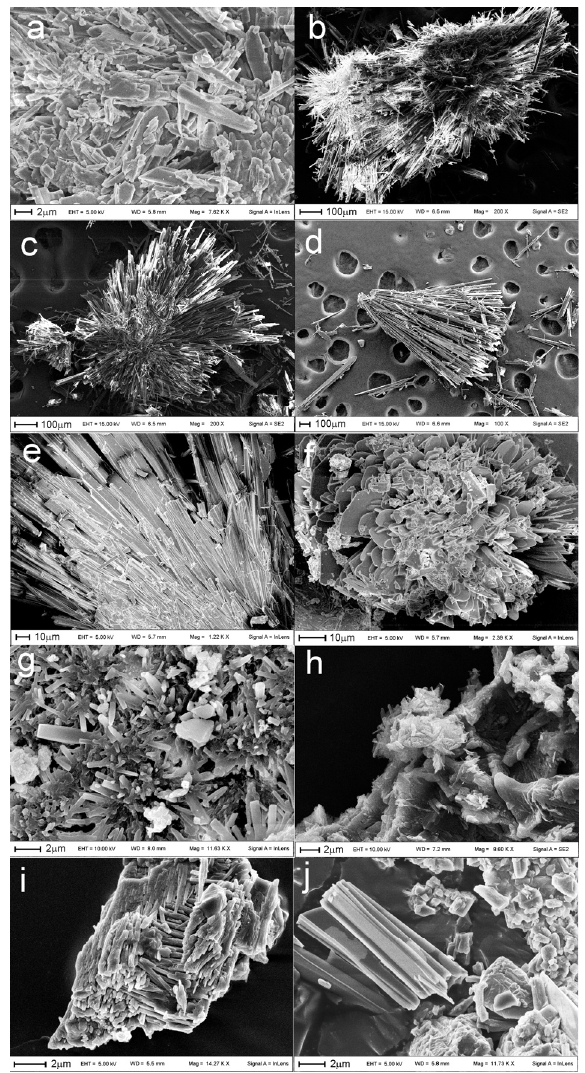
Figure 5. SEM images of Pristine-Tax ( a ); Tax-ET ( b ); Tax-ME ( c ); Tax-CH-ME ( d ); Tax-ACN ( e ); Tax-EA ( f ); Tax-AET ( g ); Tax-AACN ( h ); Tax-AC ( i ); Tax-DM-ET ( j